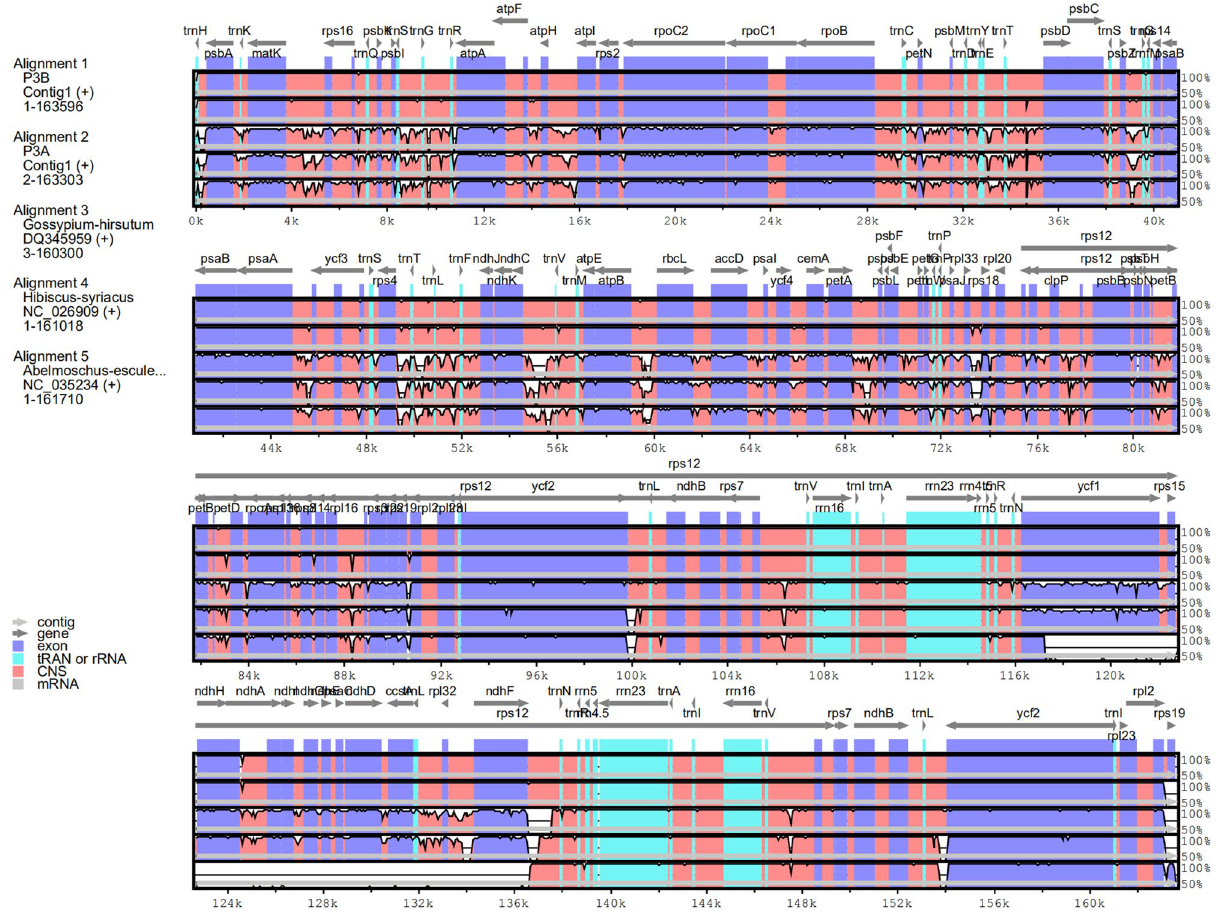
Figure 3. Comparison of the cp genome sequence of P3B, P3A, Hibiscus syriacus Linn , Abelmoschus esculentus , and Gossypium